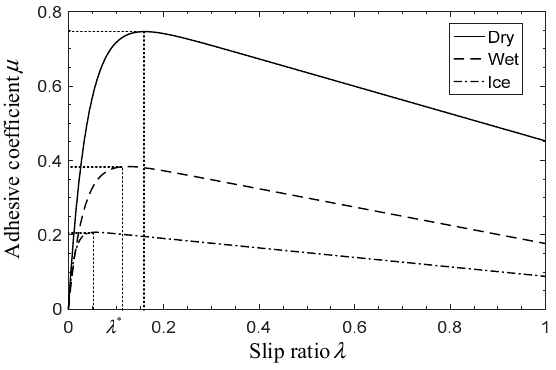
Figure 3. Slip ratio-adhesive coefficient model.